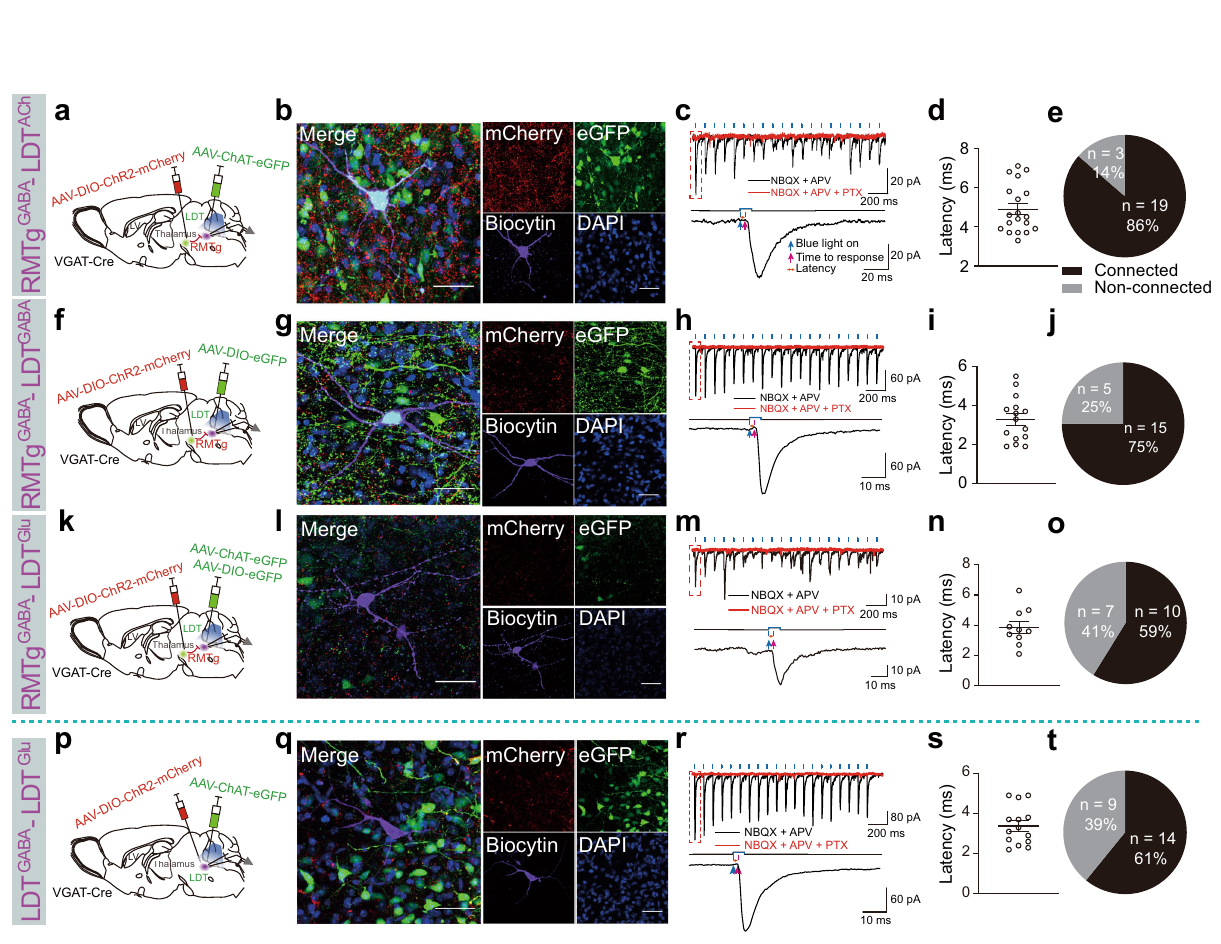
Fig. 6 | RMTg GABAergic neurons directly inhibited LDT cholinergic, GABAergic, and glutamatergic neurons and indirectly disinhibited LDT glu- tamatergic neurons. a – o RMTg GABAergic terminals formed inhibitory connec- tions with laterodorsal tegmentum (LDT) cholinergic, GABAergic, and glutamatergicneurons. p – t WithintheLDT,GABAergicneuronsformedinhibitory connections with glutamatergic neurons. a , f , k , p Schematic diagrams of the experimental protocols. In VGAT-Cre mice, Cre-dependent AAVs encoding ChR2 was injected into the RMTg ( a , f , k ) or the LDT ( p ), whereas AAVs encoding the promoter of cholinergic neurons (ChAT-eGFP) ( a ), DIO-eGFP ( f ), ChAT-eGFP and DIO-eGFP ( k ), or ChAT-eGFP ( p ) were injected into the LDT of VGAT-Cre mice. b , g , l , q Representative images showing a recorded biocytin- fi lled neuron (violet) thatisacholinergicneuron(ChAT-eGFP:green)( b ),GABAergicneuron(DIO-eGFP: green) ( g ), a glutamatergicneuron with no eGFPexpression ( l ),and glutamatergic neuronwithnoeGFPormCherryexpression( q ).Scalebar:50 μ m. c , h , m , r Typical traces ofinhibitorypostsynapticcurrents (IPSCs) from anLDT cholinergic neuron